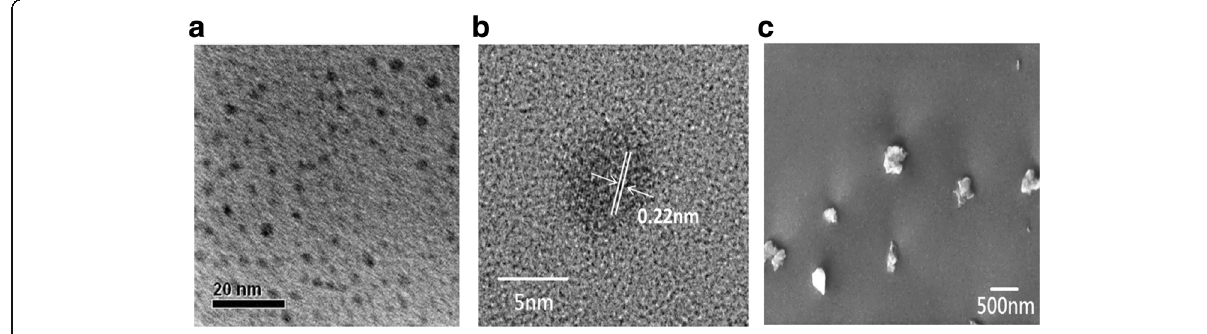
Fig. 2 Transmission electron microscopy and scanning electron microscopy images of NPs. a Morphology of the graphene QD mixture with a particle size of approximately 5 nm as characterized through a TEM and b high-resolution TEM. c SEM image (top view) of the 40 nm – 500 nm silicon